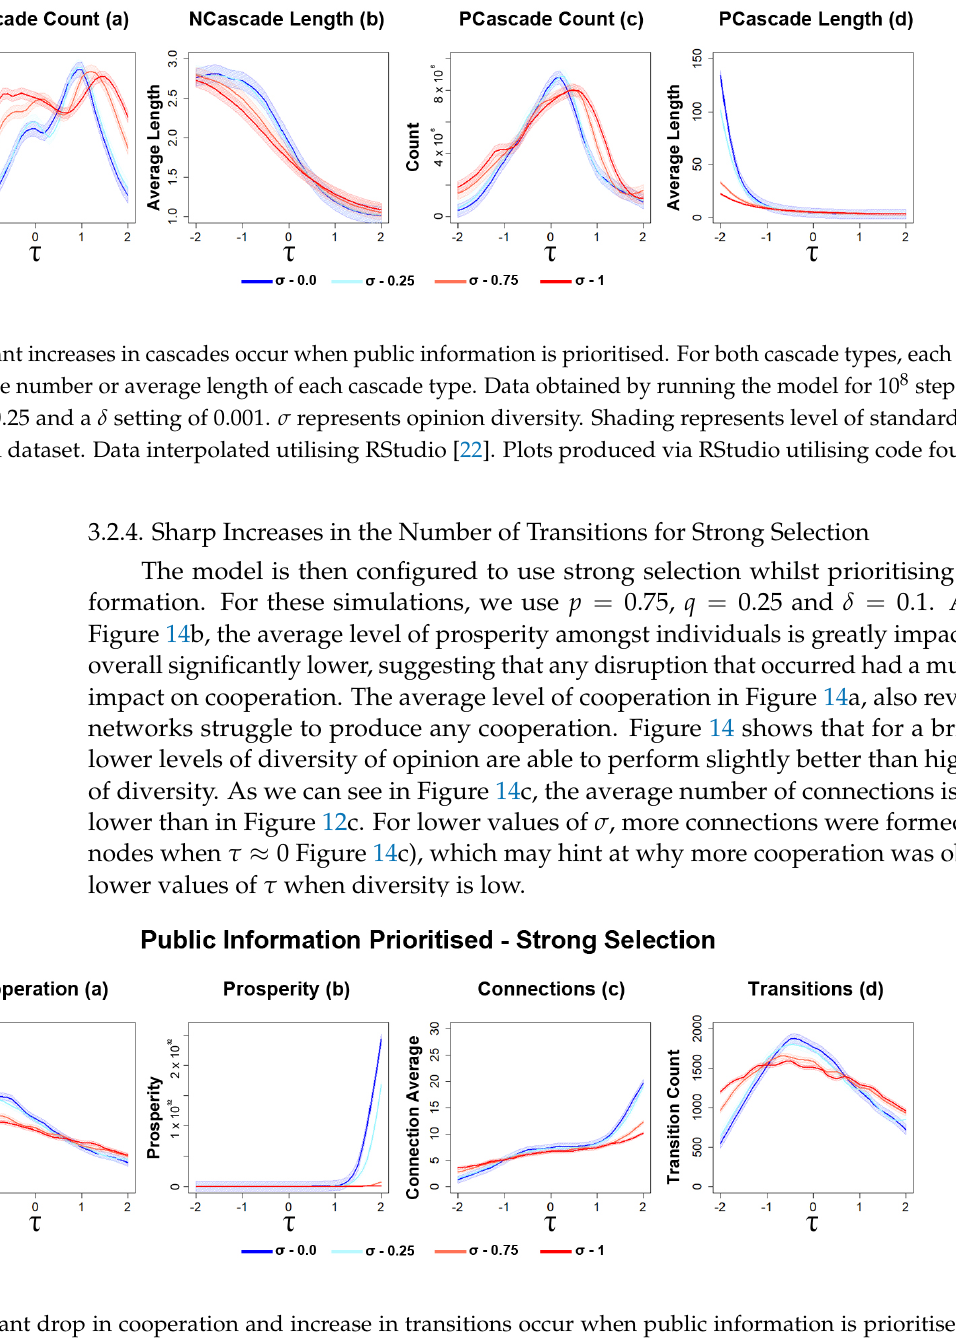
Figure 14. Significant drop in cooperation and increase in transitions occur when public information is prioritised and selection is strong. The plots visualise and compare the metrics of cooperation, prosperity, average connectivity and number of transitions for differing levels of opinion diversity. Data obtained by running the model for 10 8 steps with p = 0.75 and q = 0.25 and a δ setting of 0.1. τ represents the decision threshold. σ represents opinion diversity. Shading represents level of standard error calculated for each dataset. Data interpolated utilising RStudio [22]. Plots produced via RStudio utilising code found in Appendix